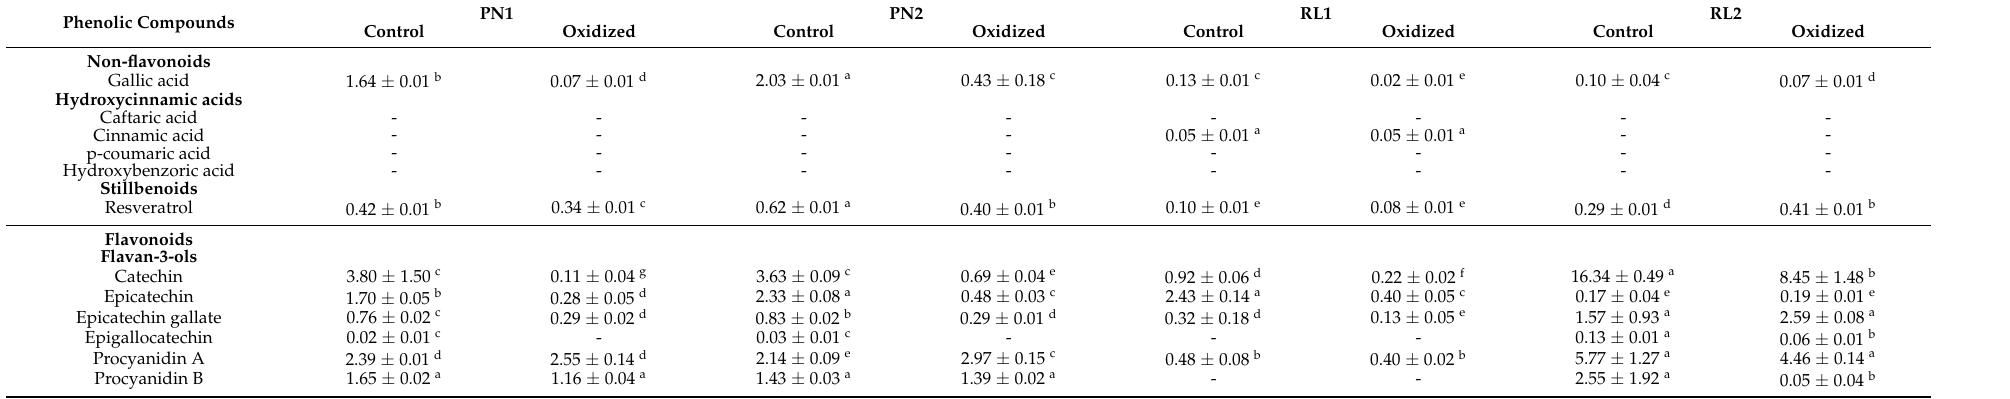
Table 4. Phenolic profile of the Pinot noir and Riesling wine lees (control and oxidized) quantified by LC-MS